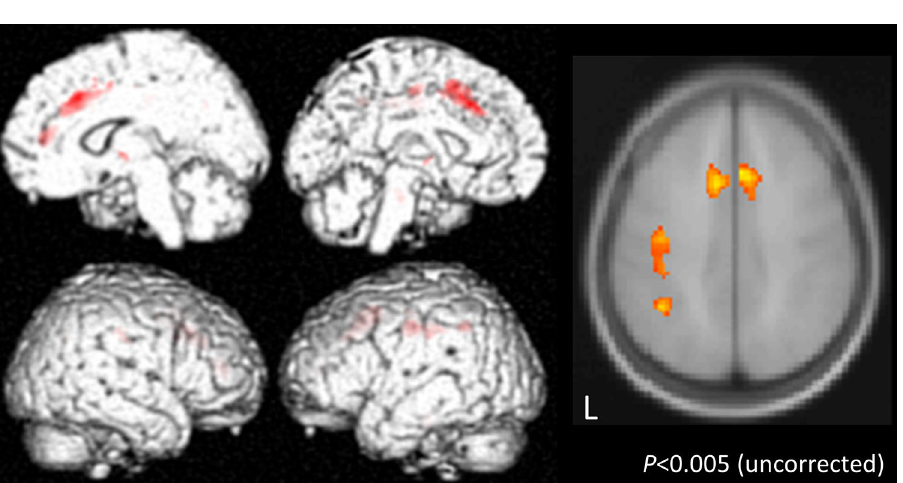
Figure 2. Voxel-based morphometry (VBM) comparing the CBS and PD groups. VBM analysis was performed on PD and CBS patients who had symptoms on the right side. The following area volumes were significantly decreased in the CBS group compared to the PD group: the left postcentral gyrus and precentral gyrus, and both sides of the supplementary motor